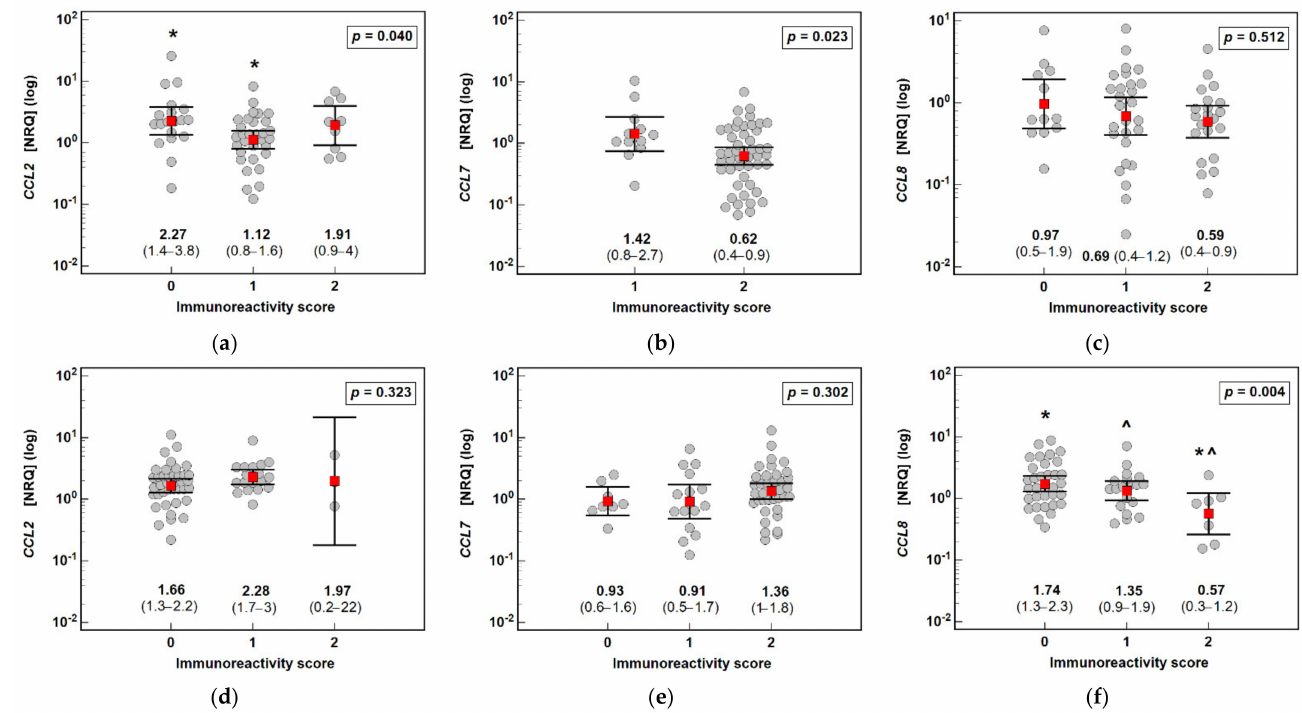
Figure 9. Correlation between the expression of MCP chemokines at the transcriptional and protein levels: ( a ) CCL2 in polyps; ( b ) CCL7 in polyps; ( c ) CCL8 in polyps; ( d ) CCL2 in normal mucosa; ( e ) CCL7 in normal mucosa; and ( f ) CCL8 in normal mucosa. Data analyzed as logarithms using one-way ANOVA with a Student–Newman–Keuls post hoc test and presented as means with 95% confidence intervals (red squares with whiskers and numbers below dot plots). Significant ( p < 0.05) differences between groups (identified in post hoc analysis) are indicated by the same symbol type (*, ˆ). NRQ: normalized relative